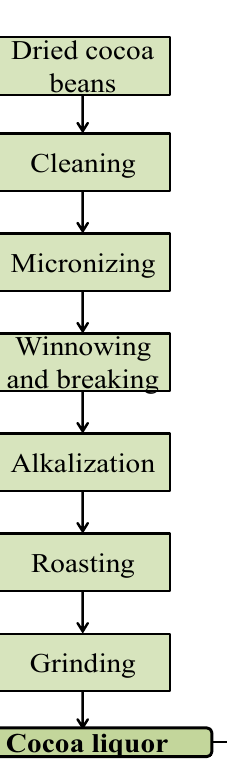
Figure 1. Manufacturing processes of cocoa